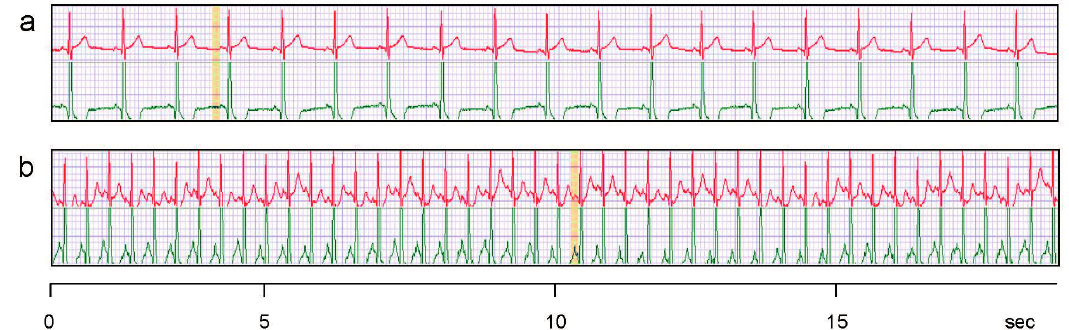
Figure 6. Electrode signals. Red : 2 embroidered moist electrodes with Ag/Ti coating worn with the belt; Green : 2 classical Ag/AgCl gel electrodes placed diagonally over the heart (Ambu Blue Sensor by Synmedic AG, Zurich, Switzerland). For details see Figure 3. ( a ) At rest (pulse 63); ( b ) In motion (pulse